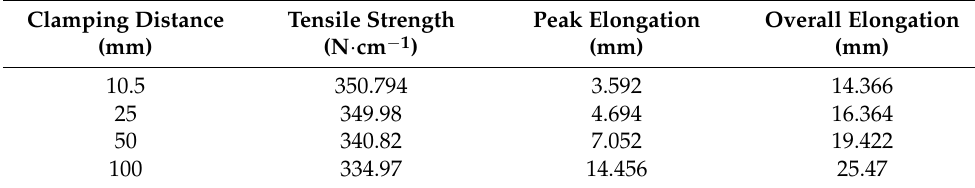
Table 3. Weld tensile test results of the junctions.